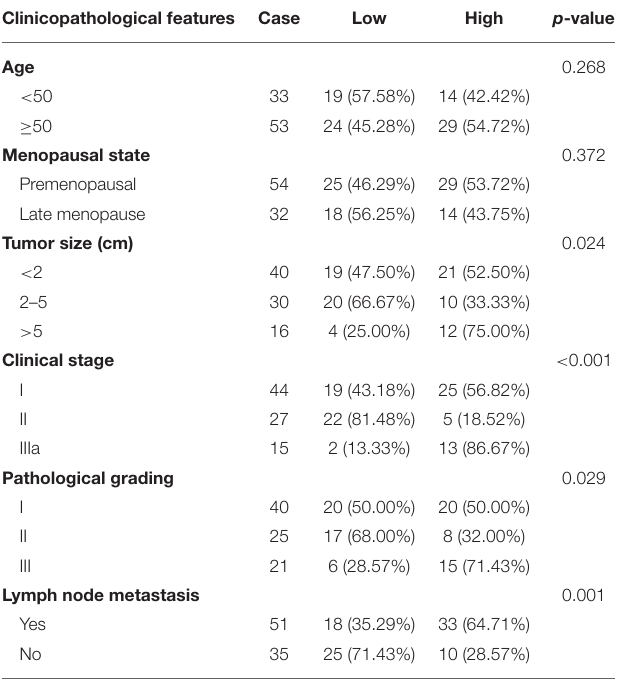
TABLE 2 | Relationship between hsa_circRPPH1_015 and clinicopathological features of patients. Clinicopathological features